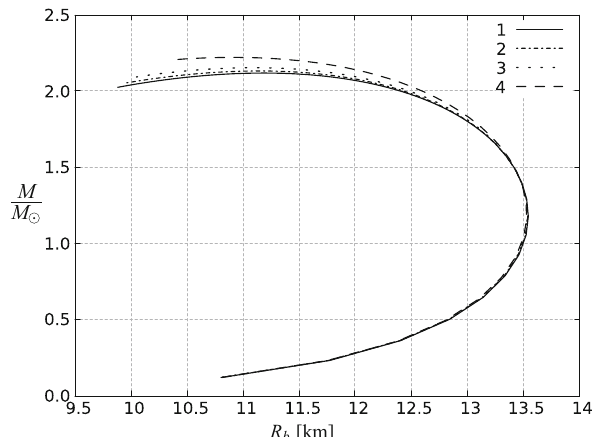
Fig. 1 Mass–radius relation for compact objects with LQG-inspired corrections and polytropic EoS with γ = 2 . 5 and k = 7 . 454 × 10 − 3 (in cgs units). The solid curve (1) shows the purely relativistic case. The dashed curve (2) is obtained for ρ cr = 10 17 g / cm 3 , the dotted curve (3) is obtained for ρ cr = 4 × 10 16 g / cm 3 , the dash-dotted curve (4) is obtained for ρ cr = 1 . 5 × 10 16 g / cm 3 . See Table 1 for details